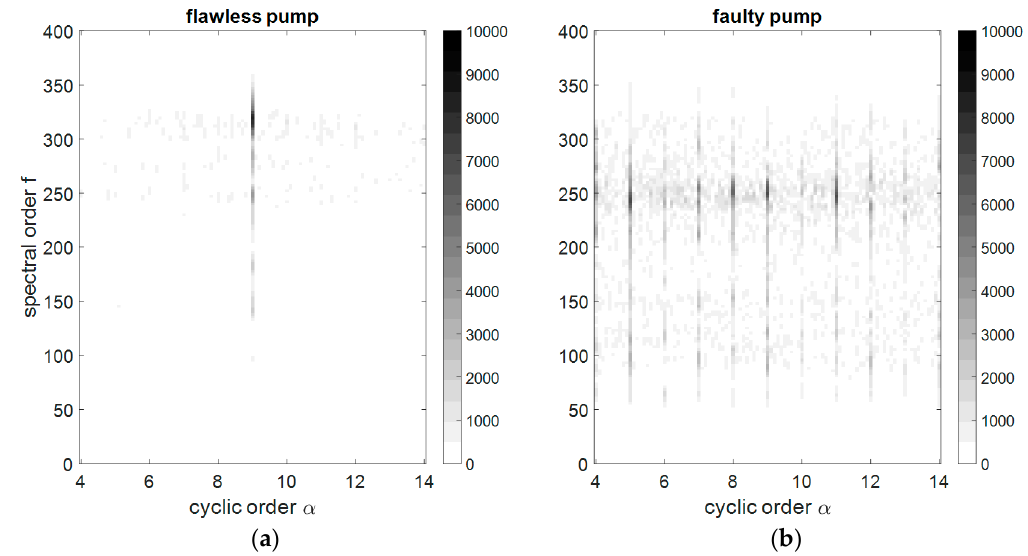
Figure 14. SCD around the cyclic order 9 for the signals acquired with sensor 2 at 1500 r/min and 150 bar ( ∆ α = 0.1, ∆ f = 2.5). ( a ) flawless pump; ( b ) faulty pump.